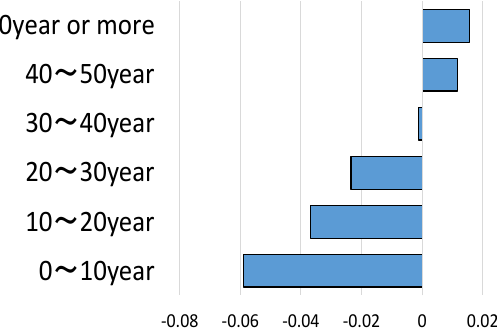
Figure 11. Years in service category scores (substructure).